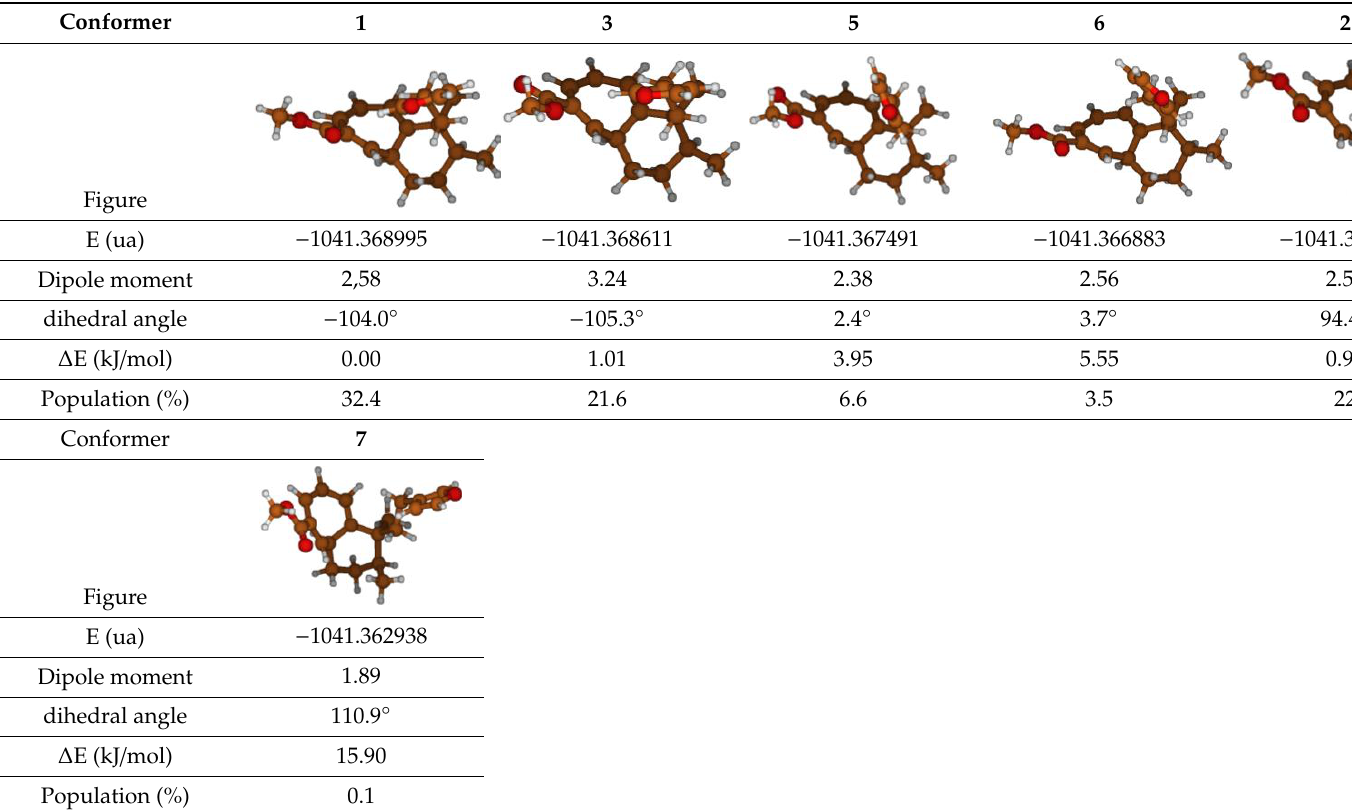
Table 11. Calculated B3LYP / 6-311 + G(d,p) Energies a , Dipole moments (Debye), relatives Energies a , (C13-C14-C15-C18) dihedral angle, equilibrium population at 25 ◦ C Table 11. Calculated B3LYP/6-311+G(d,p) Energies a , Dipole moments (Debye), relatives Energies a , (C13-C14-C15-C18) dihedral angle, equilibrium population at Table 11. Calculated B3LYP/6-311+G(d,p) Energies a , Dipole moments (Debye), relatives Energies a , (C13-C14-C15-C18) dihedral angle, equilibrium population at Table 11. Calculated B3LYP/6-311+G(d,p) Energies a , Dipole moments (Debye), relatives Energies a , (C13-C14-C15-C18) dihedral angle, equilibrium population at Table 11. Calculated B3LYP/6-311+G(d,p) Energies a , Dipole moments (Debye), relatives Energies a , (C13-C14-C15-C18) dihedral angle, equilibrium population at Table 11. Calculated B3LYP/6-311+G(d,p) Energies a , Dipole moments (Debye), relatives Energies a , (C13-C14-C15-C18) dihedral angle, equilibrium population at and figures of conformations 1-7 of the 1 S , 8 S , 9 S isomer of methyl iso-dodovisate A ( 3 ). Table 11. Calculated B3LYP/6-311+G(d,p) Energies a , Dipole moments (Debye), relatives Energies a , (C13-C14-C15-C18) dihedral angle, equilibrium population at 25°C and figures of conformations 1-7 of the 1 S , 8 S , 9 S isomer of methyl iso-dodovisate A ( 3 ). 25°C and figures of conformations 1-7 of the 1 S , 8 S , 9 S isomer of methyl iso-dodovisate A ( 3 ). Table 11. Calculated B3LYP/6-311+G(d,p) Energies a , Dipole moments (Debye), relatives Energies a , (C13-C14-C15-C18) dihedral angle, equilibrium population 25°C and figures of conformations 1-7 of the 1 S , 8 S , 9 S isomer of methyl iso-dodovisate A ( 3 ).